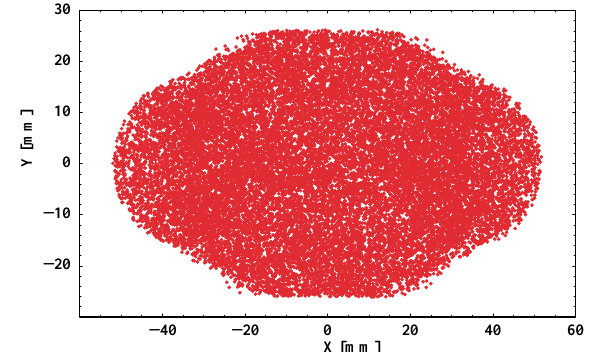
FIG. 21. (Color) ACCSIM run for initially symmetric distribution. X - Y projection after 40